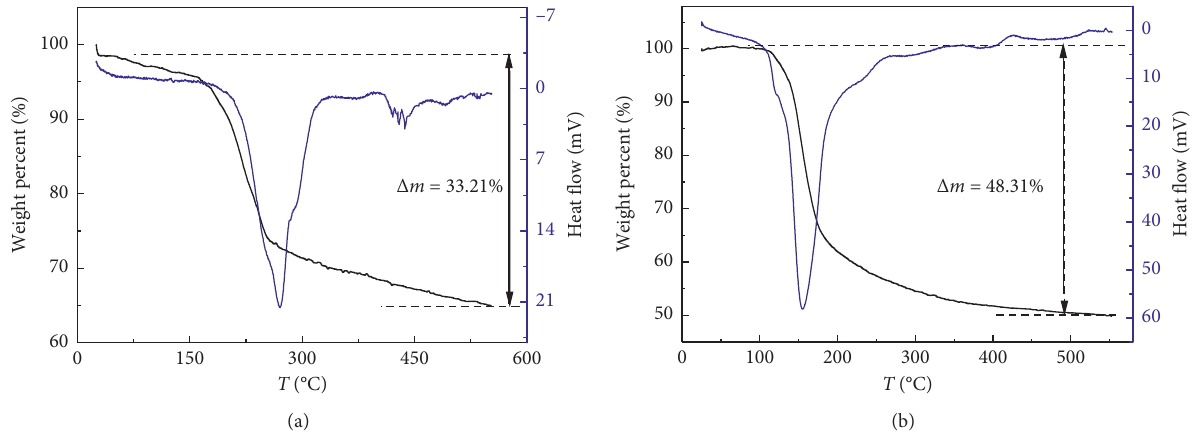
Figure 2: The TG-DSC curves of pinnoite (a) and inderite